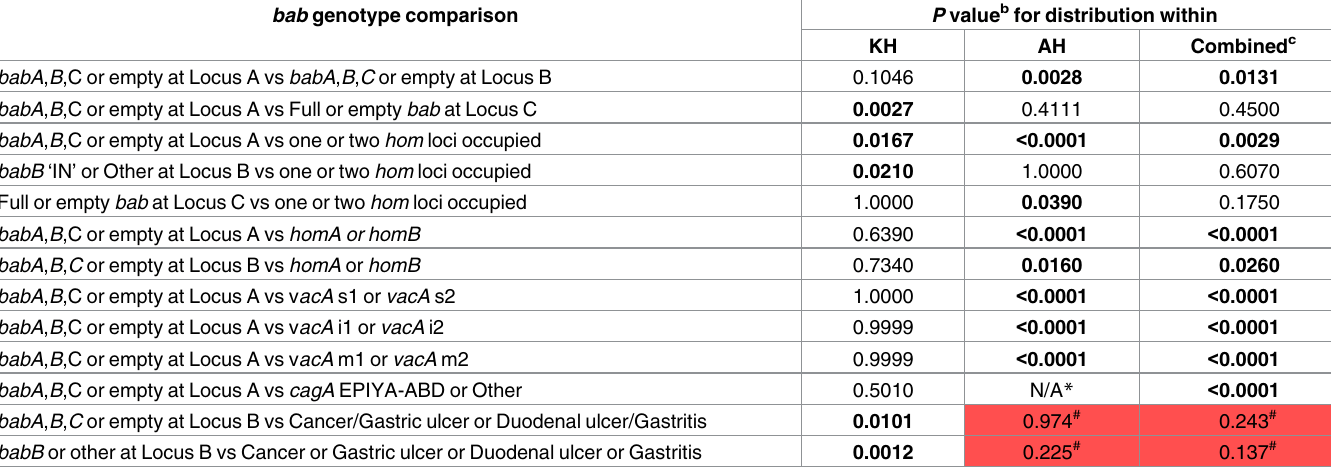
Table 3. Significant two-way comparisons of bab genotype and other factors in both populations a .